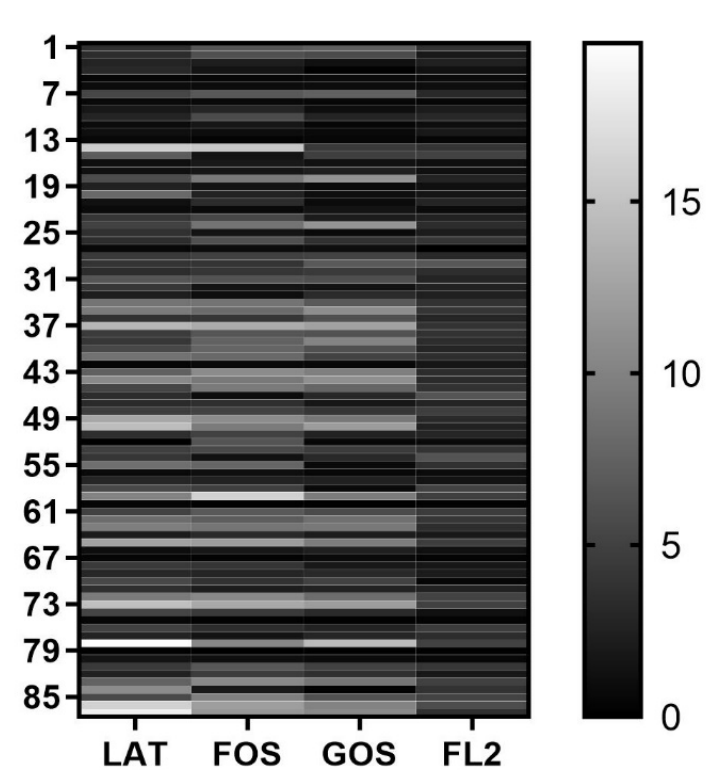
Figure 2. Heat map analysis of fecal samples based on gas production in different media by in vitro fermentation modeling system. Rows for different samples. Columns for different fermentation media. LAT, lactose; FOS, fructooligosaccharide; GOS, galactooligosaccharide; FL2, 2 ′‐ fucosyllactose.